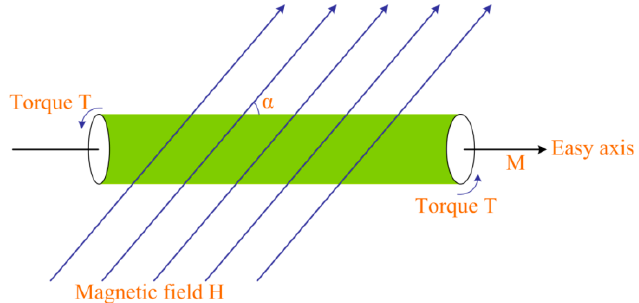
Figure 2. Schematic of torque calculation under tilt magnetic field.